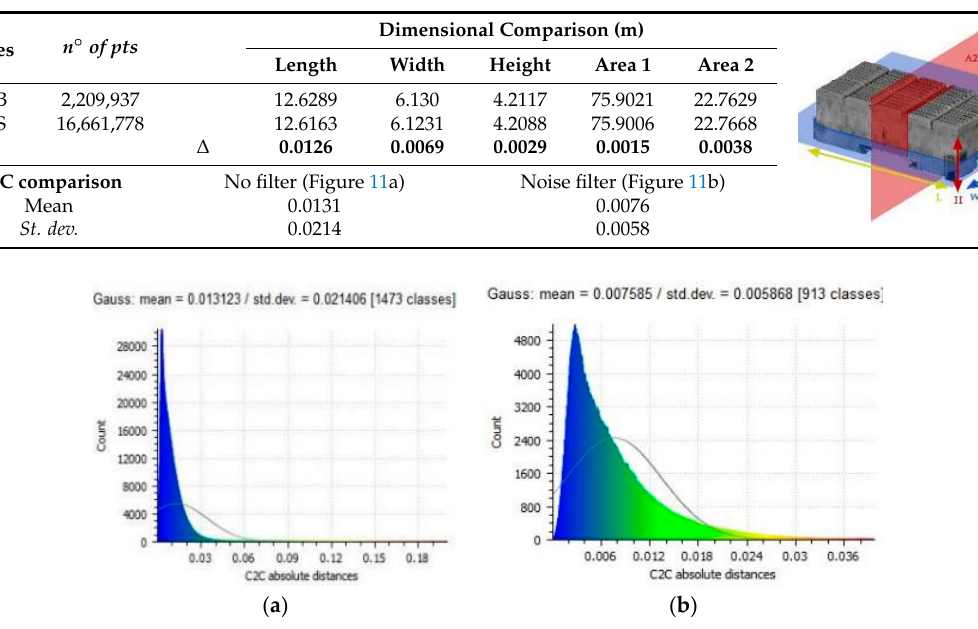
Figure 11. Statistical graphics of C2C comparison of ZEB and LiDAR point clouds on the Throne Chamber : mean and st. dev. distribution ( a ) before and ( b ) after noise filtering applied to ZEB data (C 1 - C 2 cases). Table 5. Results of (I.) Dimensional and C2C comparison of ZEB and LiDAR point clouds on the Throne Chamber.